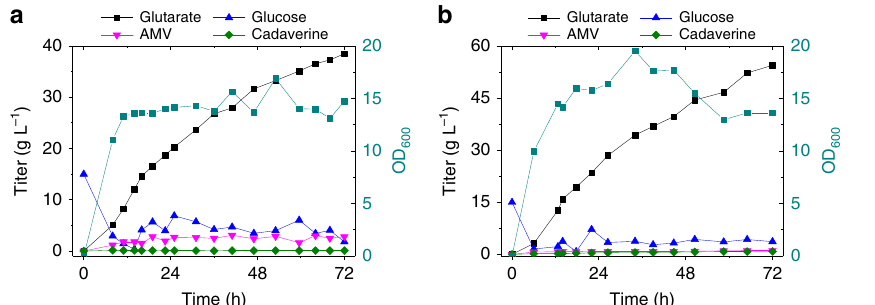
Fig. 6 Fed-batch production of glutarate in 3 L bioreactors. Strains BM31PE ( a ) and BM31PER ( b ) were used for the experiments, respectively. The minimum threshold of DO was set at 10%. The result of a duplicate experiment is shown in Supplementary Fig. 6, which results in similar titer and yield. Source data are provided as a Source Data fi